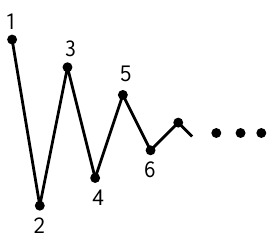
Fig. 1: A 2-periodic